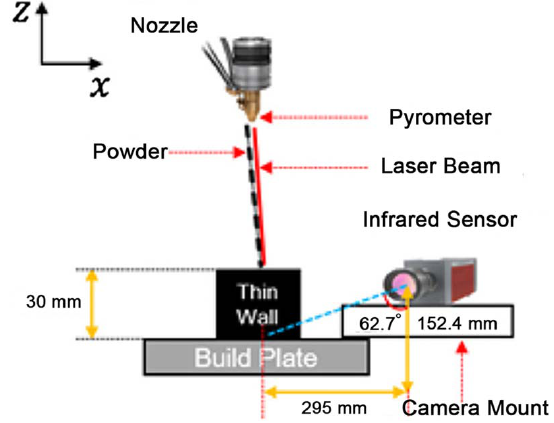
Figure 1. Setup of the pyrometer